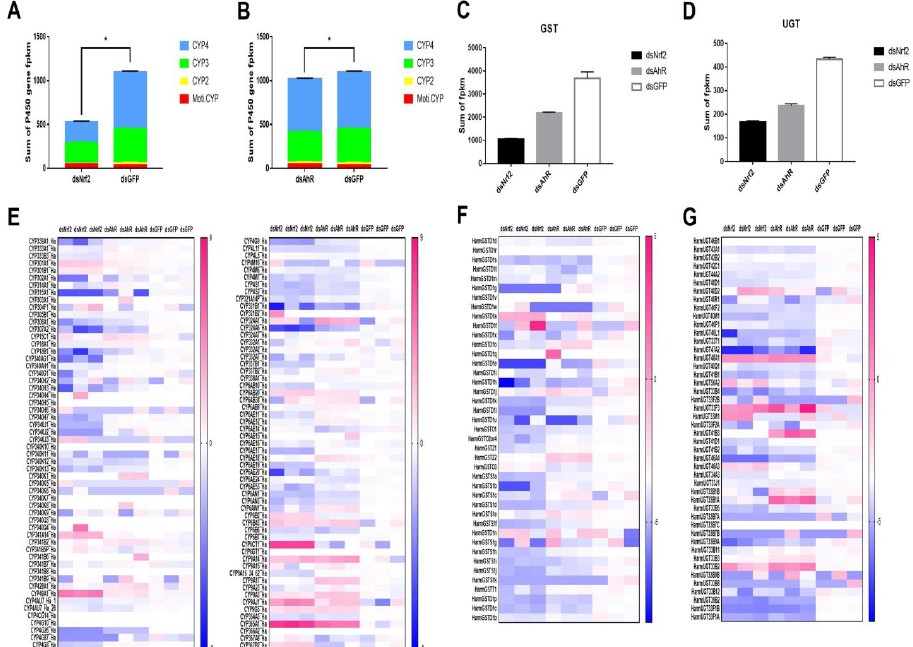
Figure 2. Down-regulation of P450 ( A , B , E ), GST ( C , F ) and UGT ( D , G ) detoxification genes putatively regulated by HaNrf2 and HaAhR . Means and SEs from three biological replicates are shown. Asterisks on error bars show significant differences ( p < 0.05).